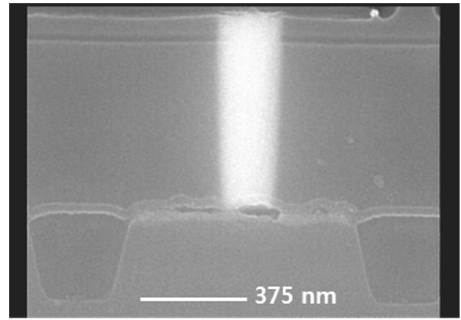
Figure 5. Cross section SEM image of specimens treated with a buffered oxide etch (BOE) process.